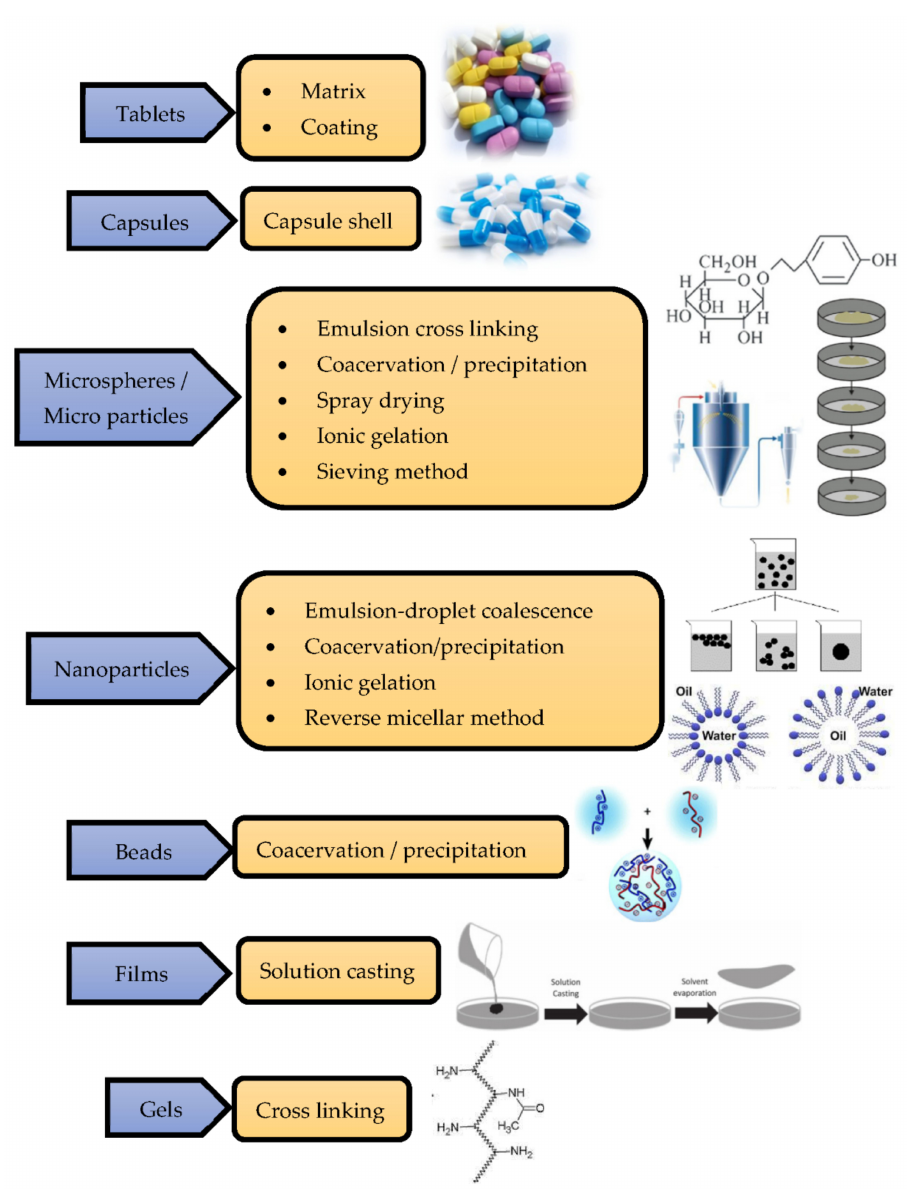
Figure 4. Processing technologies for making products using